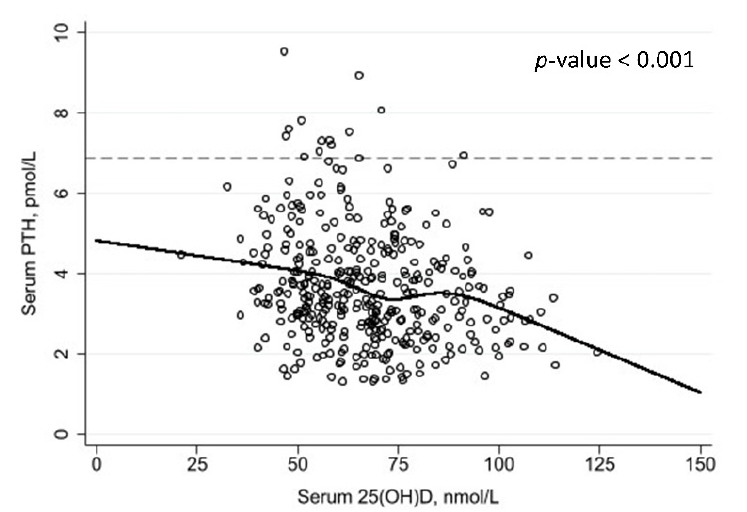
Figure 3. Serum concentrations of 25(OH)D vs. parathyroid hormone concentrations. Restricted cubic spline fitted (5 knots); reference line: 6.9 pmol/L. Table 3. PTH concentrations above and below the upper limit of normal range (6.9 pmol/L) stratified by serum 25(OH)D concentrations.